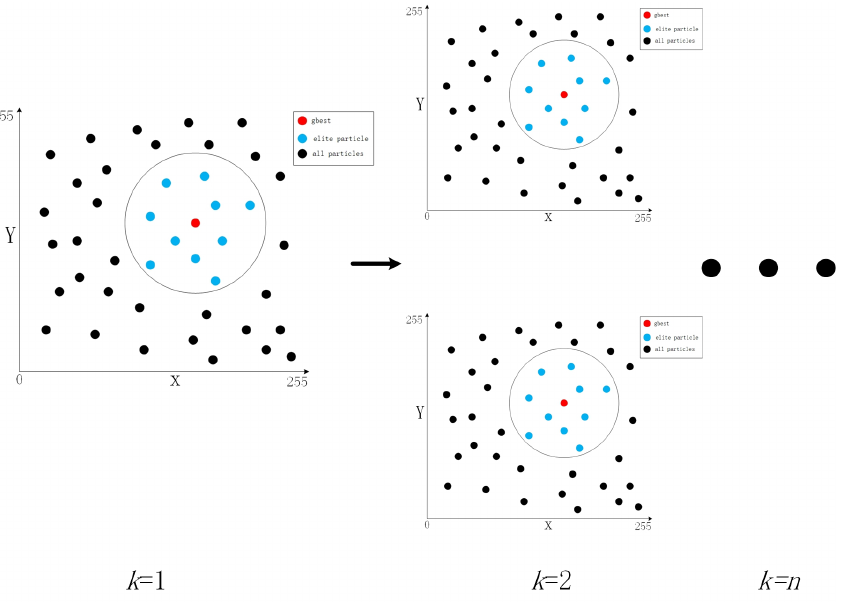
Figure 1. Particle swarm narrows the search range according to the contribution of particles. Taking the gray value range of the segmented image as the coordinate range of x and y values, the black dot as all particles, and the central red dot as the global optimal solution gbest of the current iteration, the search range can be reduced to a black circular region, that is, the region where the elite particles are located, and k is the number of threshold values. Each threshold requires a corresponding particle swarm to determine, while